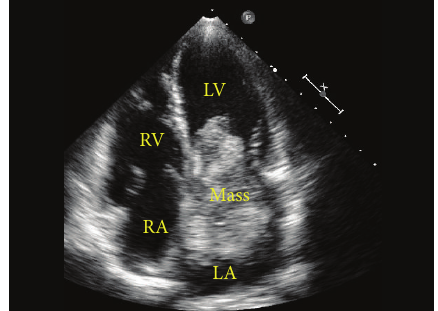
Figure 2: Echocardiography before surgical resection. Transeso- phageal four-chamber view showed a pedunculated mobile mass in the left atrium arising from the atrial septum. There was no thrombus in the left atrial appendage. LA: left atrium, LV: left ventricle, RA: right atrium, and RV: right ventricle.